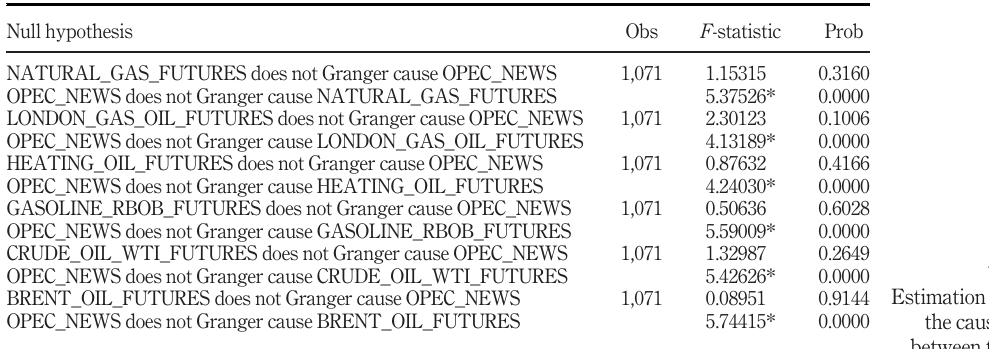
Table 4. Estimation results